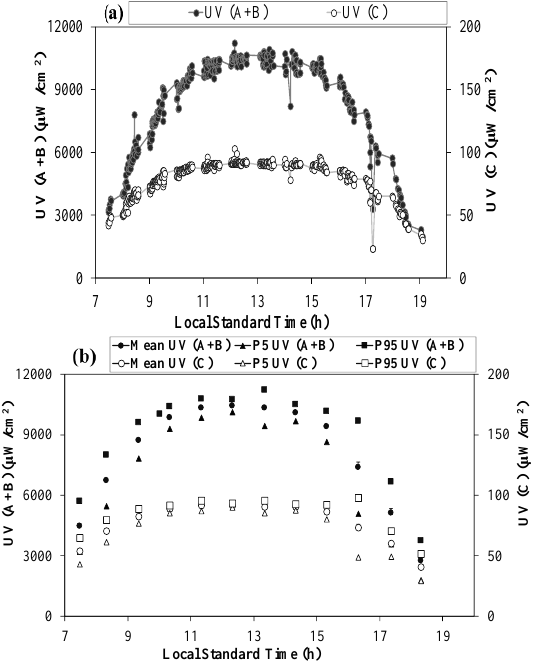
Figure 2 . Daily patterns of UV (A+B) and UV (C) solar irradiances (a), under clear sky conditions: for the period (June 2019). Hourly mean, and percentiles P5 and P95 of UV (A+B) and UV (C) solar irradiances